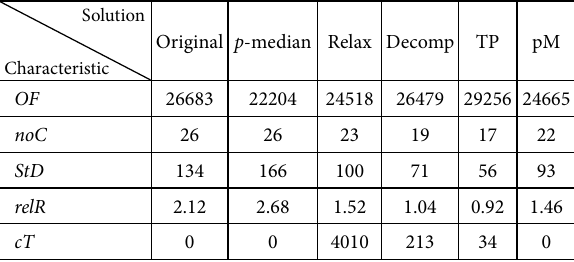
Table 5. Comparison of the results for the region TN